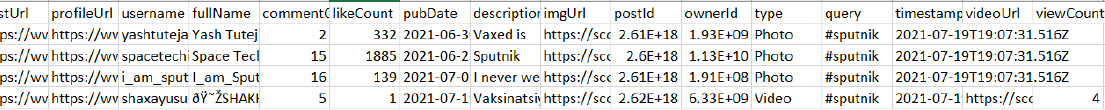
Figure 6. The #sputnik post metadata with additional details such as the URL, likeCount, viewCount, and others .